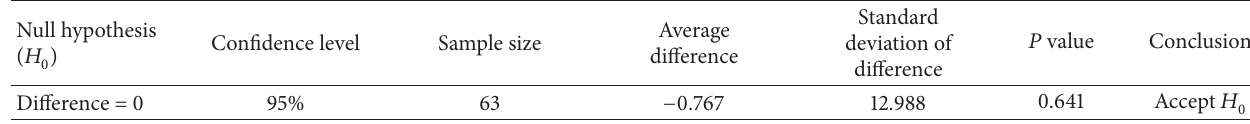
Table 2: 𝑡 -test for experimental and predicted adhesion fatigue lives.